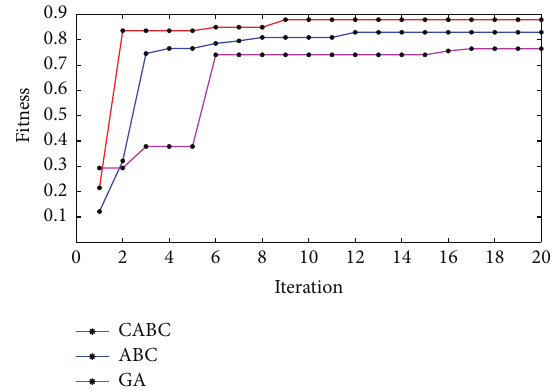
Figure 11: Evolutionary curves of CABC, ABC, and GA.